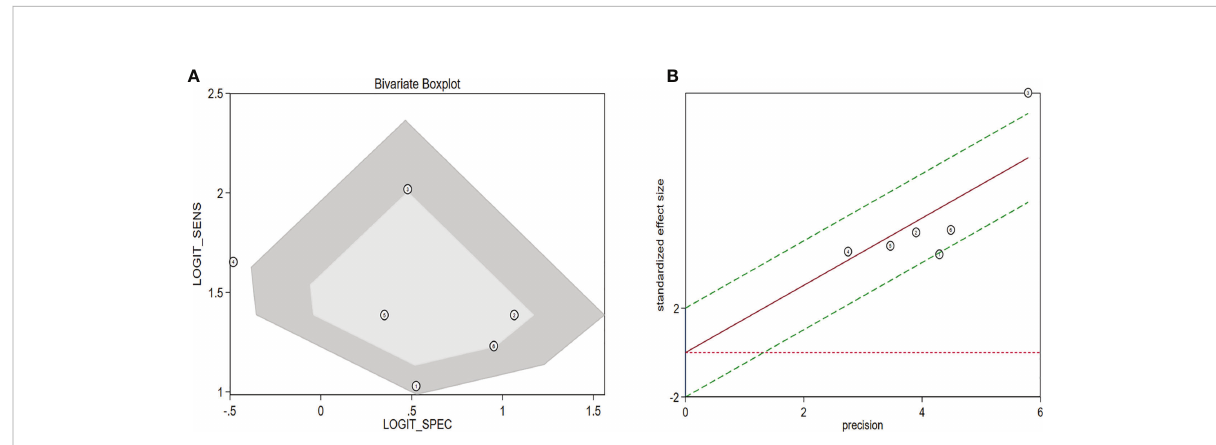
FIGURE 5 Assessment of the diagnostic accuracy of circRNAs in PCa. (A) Bivariate boxplot. (B) Galbraith plot. circRNAs, circular RNAs; PCa, prostate